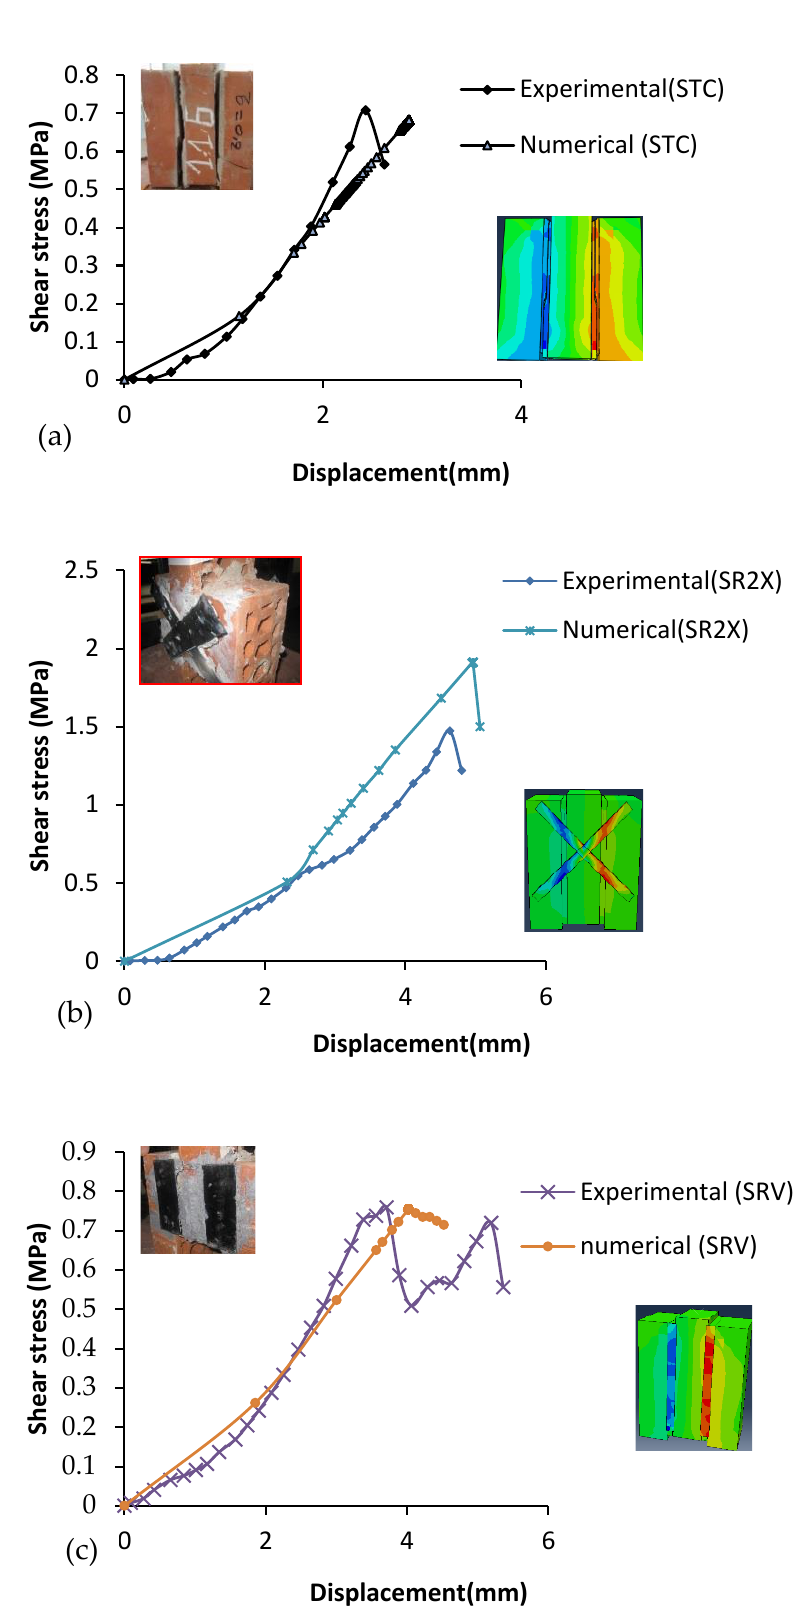
Figure 12. Comparative assessment between numerical results and experimental test of non-reinforced and reinforced masonry triplets; ( a ) non-reinforced masonry triplets, ( b ) Retrofitted with diagonal CFRP strips (X form pattern); ( c ) Retrofitted with CFRP strips parallel to mortar. Overall, all the stress versus displacement curves show good accordance in numeri- cal and experimental results, and it can be stated that the models are well-calibrated.